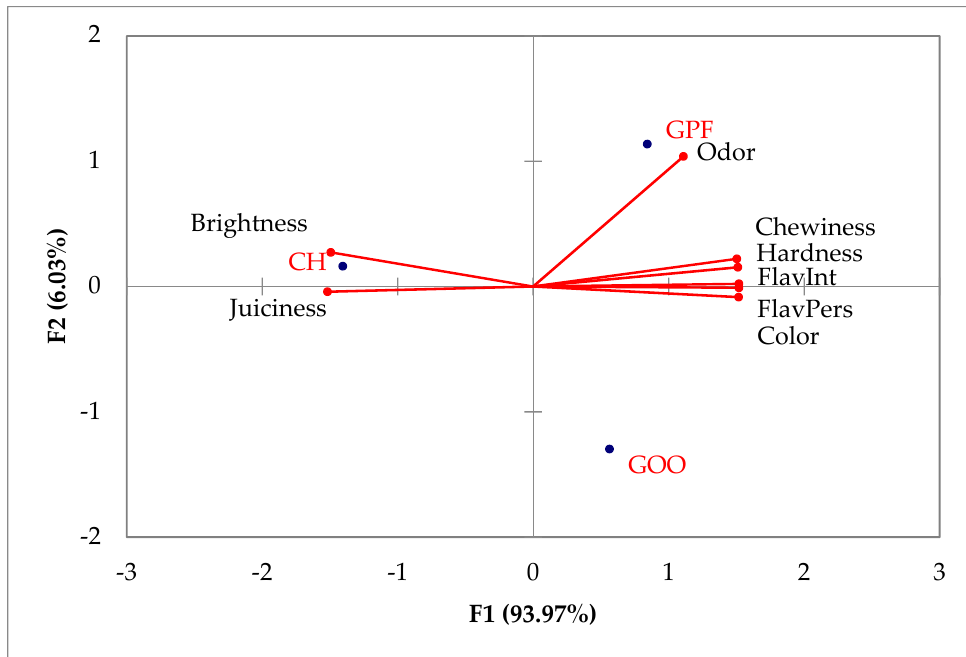
Figure 2. Consensus configuration: representation of the correlation between the sensory attributes F1 and F2 and the coordinates of the hamburgers.